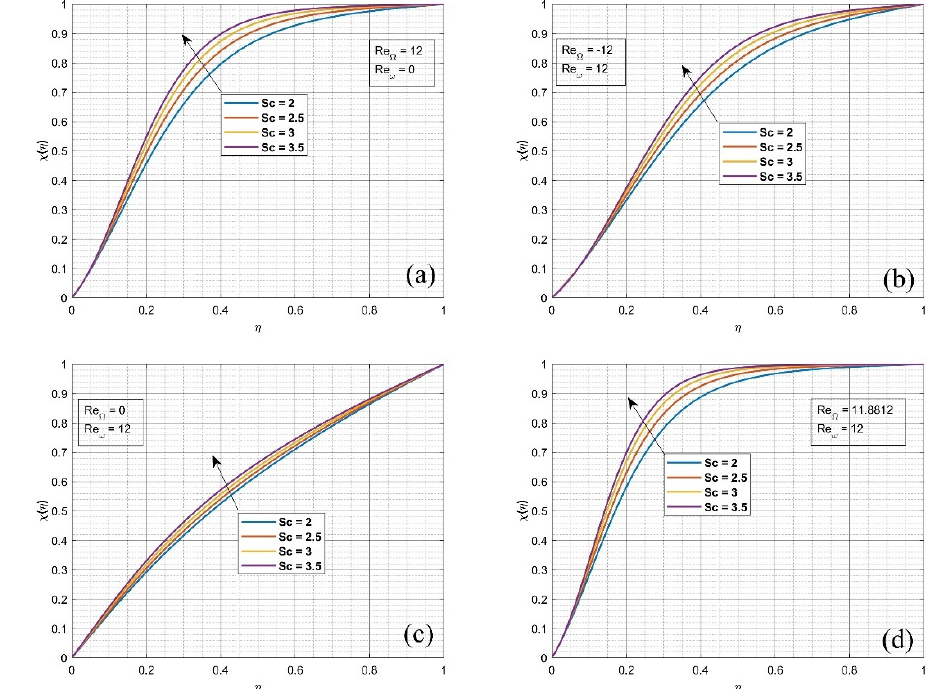
Figure 6. ( a – d ): Influence of Schmidt number on χ ( η ) ; ( a ) the scenario between a rotating cone and stationary disk; ( b ) the scenario between a counter-rotating cone; ( c ) the scenario between a rotating disk and a stationary cone; ( d ) the scenario between a co-rotating cone and disk.